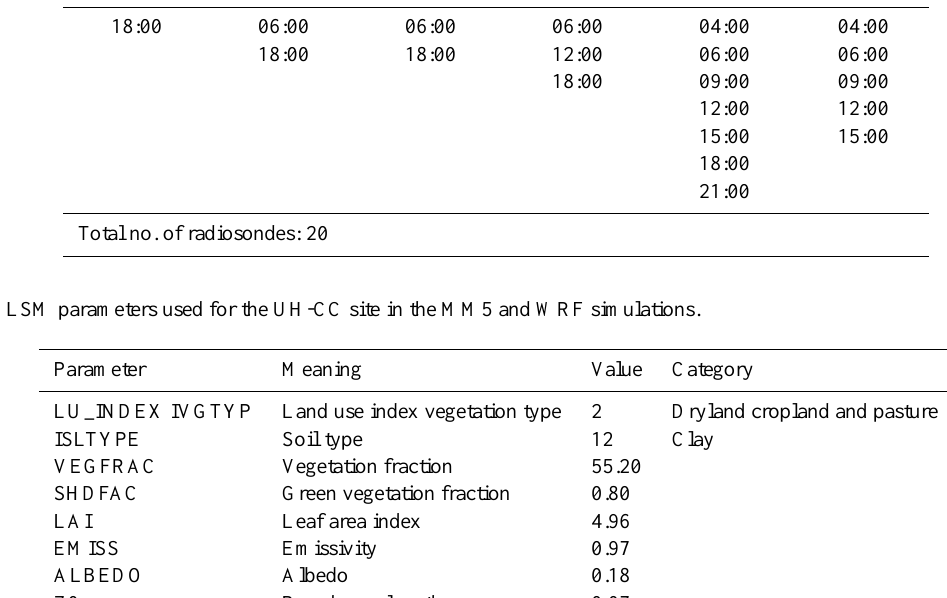
Table 2. Radiosonde launch times (CST).